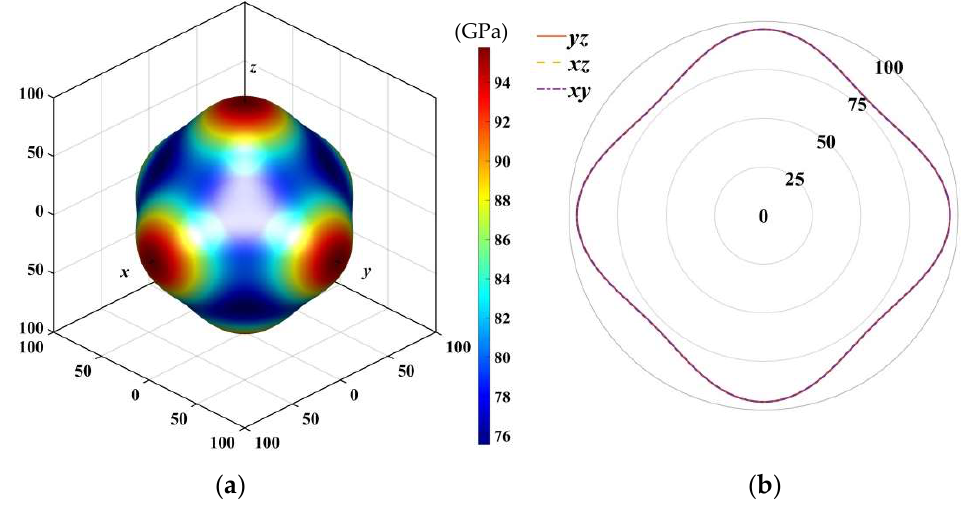
Figure 3. ( a ) 3D surface representation of Young’s modulus of Ag 9 In 4 and ( b ) 2D projections of Young’s modulus onto yz, xz, and xy planes. Table 5. Maximum and minimum Young’s moduli for Ag 9 In 4 crystal.